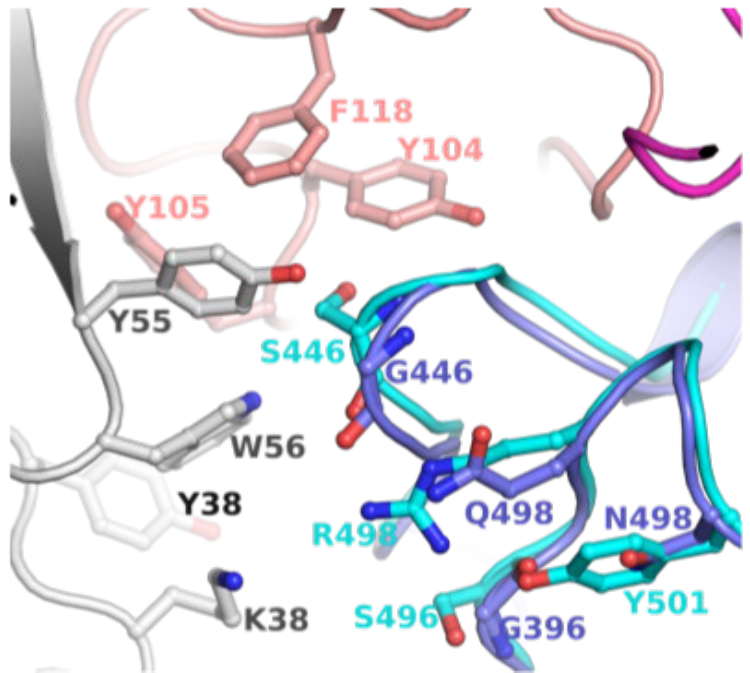
Figure 3. Position of G446/G449 in relation to mAb. This figure shows mAb (AZD1061) bound WT S-RBD (PDB file 7L7E). To assess the change in loop conformation housing G446 and S446, S-RBD of BA.1 bound to S304/309 mAbs (PDB entry 7TN0) is superposed. The WT S-RBD is rendered in purple ribbons, while BA.1 is in cyan ribbons. The heavy and light chains of AZD1061 are rendered in deep salmon and grey, respectively. The carbon atoms are the same color as the ribbons. The other atoms are colored as defined in Figure 1.